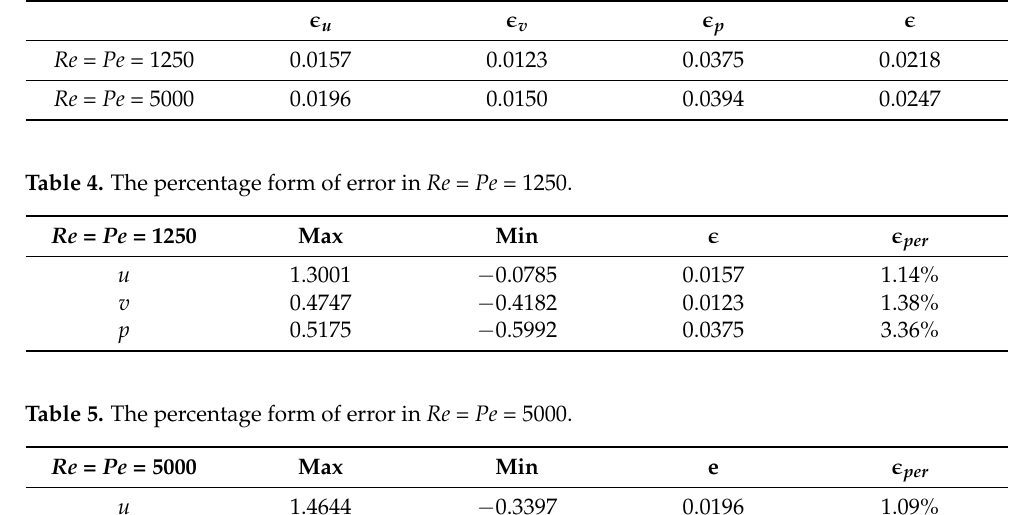
Figure 7. Comparison between predicted data and CFD data for Re = 5000: ( a ) u component; ( b ) v component; ( c ) p; ( d ) c; ( e ) mean absolute error. Table 3. Mean ϵ for u, v, and p separately and together.